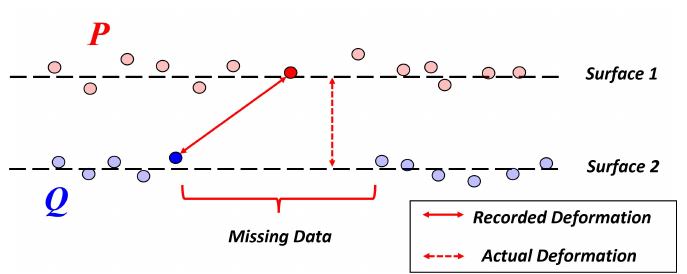
Figure 11. C2C algorithm performance in areas of missing